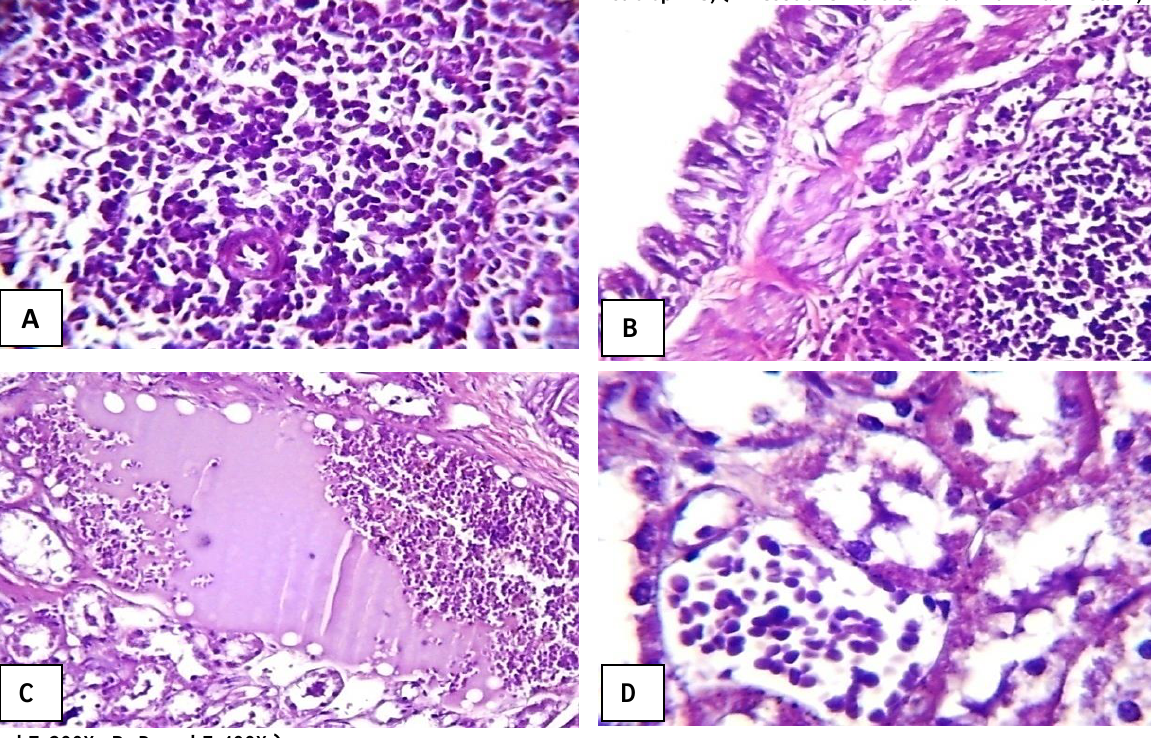
Fig, 3: Histological sections in the internal organs of the non-immunized group at 30 day post inoculation showed, A: Spleen: depletion of white pulp. B: Lung: hyperplasia of lymphoid tissue in the wall of bronchi. C: Kidney: thrombus in the blood vessels with acute cellular degeneration of epithelial lining cells of renal tubules. D: kidney: congestion of the blood vessels with inflammatory cells in their lumen, vacuolation and sloughing of epithelial lining cells of renel tubules, (All sections were stained with H & E stain; A and B 400X; C 200X; D